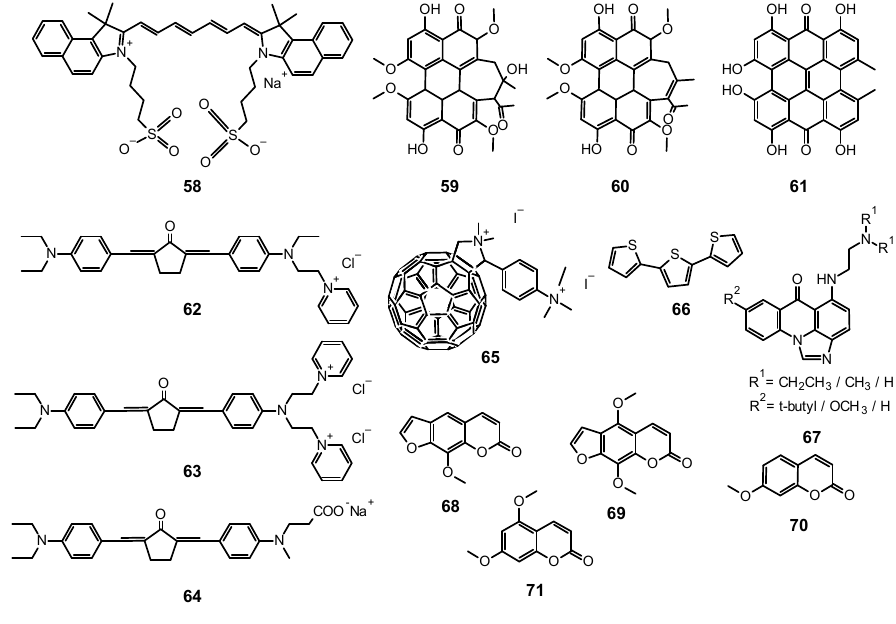
Figure 12. Chemical structures of 58–71.